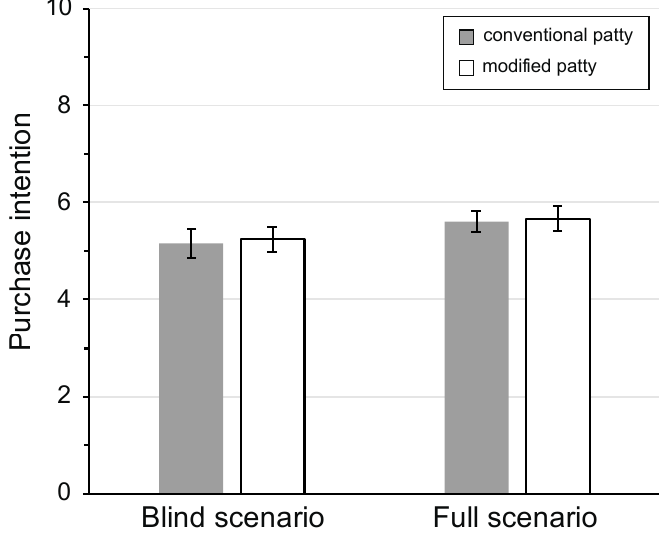
Figure 5. Purchase intention by composition and information scenario. One-way test for di ff erences in purchase intention of the two beef patties. Purchase intention (scale 1—10) where 1 = definitely would not buy, 10 = definitely would buy. Error bars denote S tandard E rror of the M ean (SEM). There were no significant di ff erences between patties in both information scenarios. Information scenario: Blind : disclosure of details of the meat origin, Full : disclosure of details of the meat origin and the ingredients used to enrich the patties in n -3 PUFA and vitamin D 3